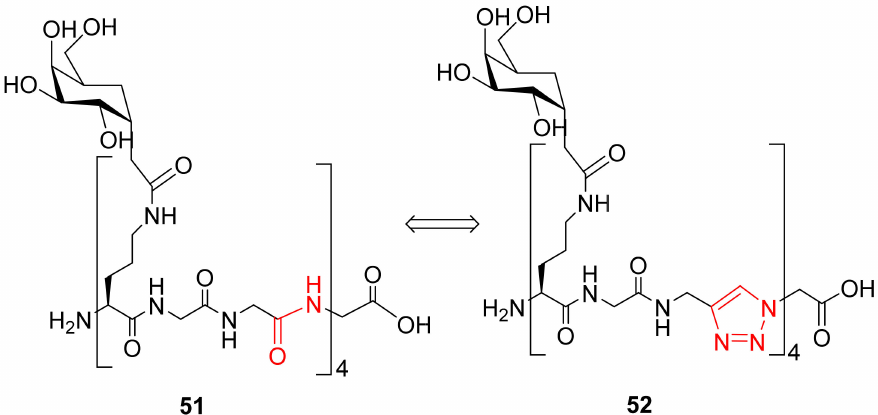
Figure 20. Comparison of AFGP 51 and its triazole-based tetramer mimetic 52 . Glycotriazole peptides derived from Hylasptin P 1 (HSP1) [74], a 14-residue